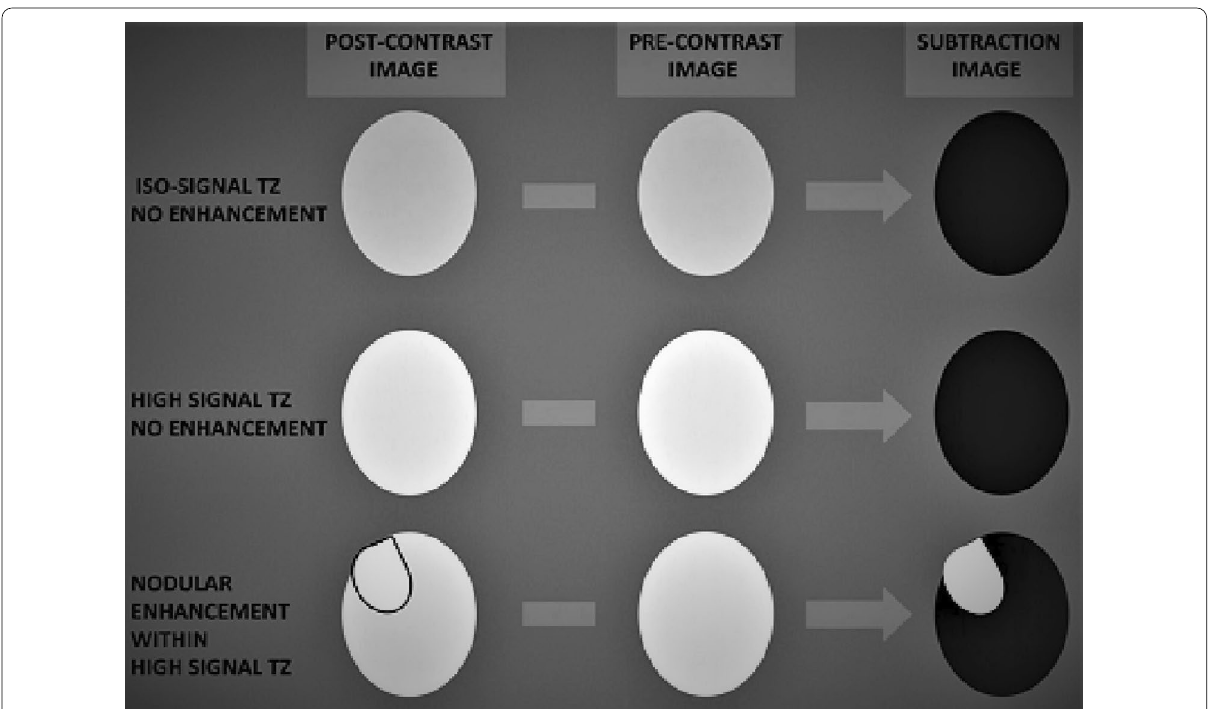
Fig. 1 Schematic diagram illustrating the principles of subtraction MRI in treatment zones of varying characteristics